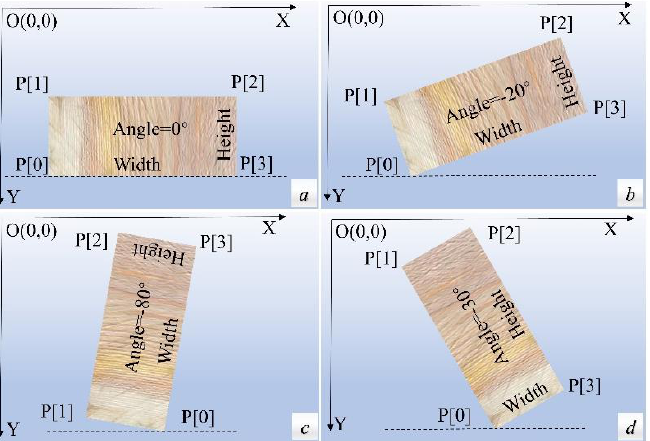
Figure 6. The minimum enclosure rectangle fitting in the case of rotation. ( a ) Angle = 0° ( b ) Angle = − 20° ( c ) Angle = 80° ( d ) Angle = − 30°.